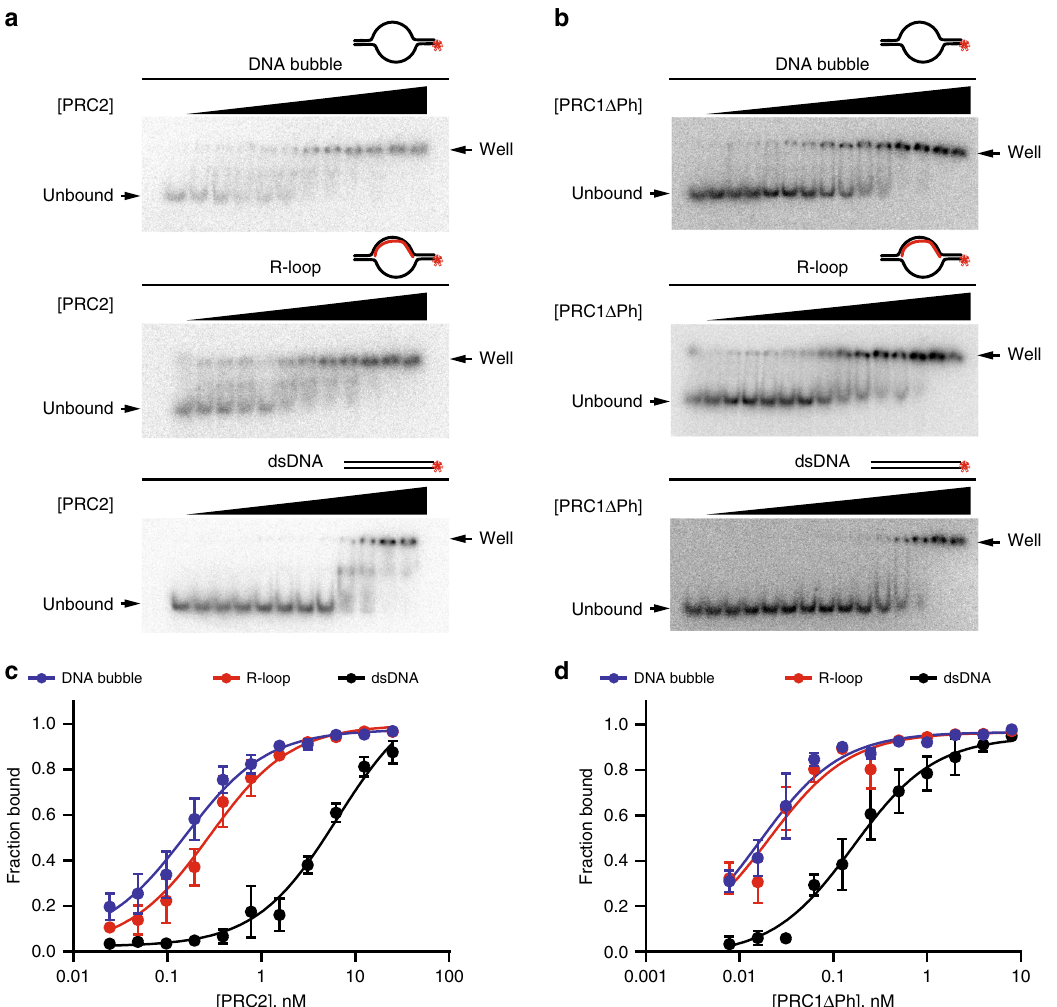
Fig. 2 PRC1 and PRC2 recognize R-loops. a , b PRC2 ( a ) and PRC1 Δ Ph ( b ) binding to open DNA bubble, R-loop and dsDNA oligonucleotides measured by EMSA. [PRC2] = 0.02 – 25 nM for DNA bubble, R-loop and dsDNA and [PRC1 Δ Ph] = 0.02 – 16 nM (active concentration). c PRC2 binding to DNA bubble, R-loop and dsDNA oligonucleotides measured by fi lter binding assay. [PRC2] = 0.02 – 25 nM, n ; = 3. Points show the mean + / − S.E.M. Apparent Kd(95% CI): DNA bubble = 0.16 nM (0.11 – 0.23); R-loop = 0.28 nM (0.20 – 0.41); dsDNA = 6.44 (4.26 – 9.99). d PRC1 Δ Ph binding to DNA bubble, R-loop and dsDNA oligonucleotides measured by fi lter binding assay. [PRC1 Δ Ph] = 0.08 – 8 nM, n = 3. Points show the mean + / − S.E.M. Apparent Kd(95% CI): DNA bubble = 0.016 nM (0.012 – 0.022); R-loop = 0.021 nM (0.014 – 0.031); dsDNA = 0.164 (0.106 – 0.254). Source data are provided in Source Data fi